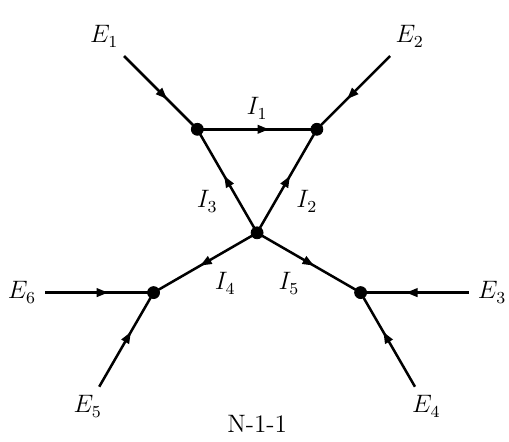
Figure 6 . Field assignments and color flow for the topology N-1-1, where E i and I i denote the external and internal fields